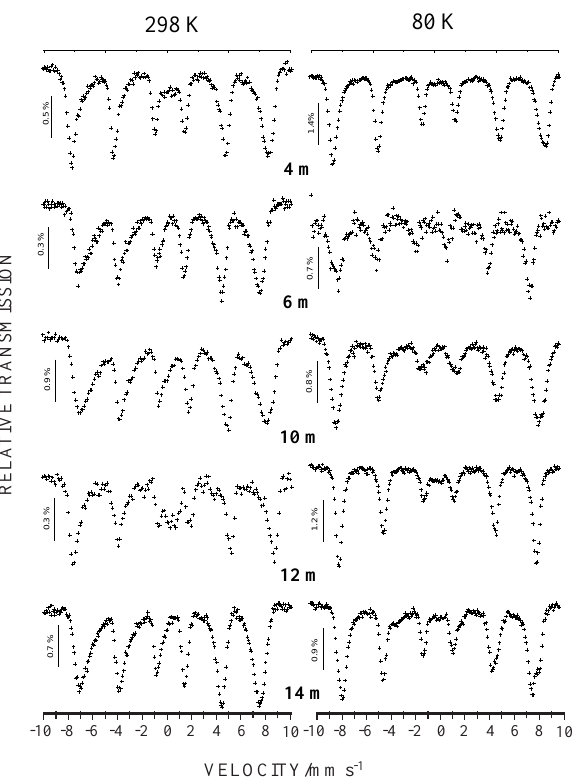
Figure 6. 298 K and 80 K Mössbauer spectra of powdered magnetic crystals.